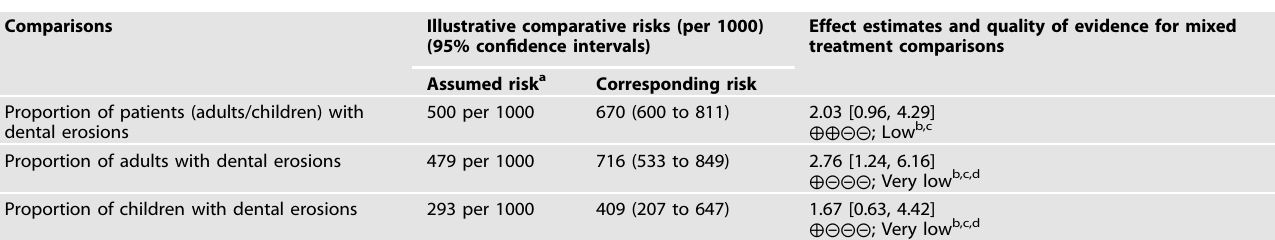
Table 4. Grading the strength of evidence.